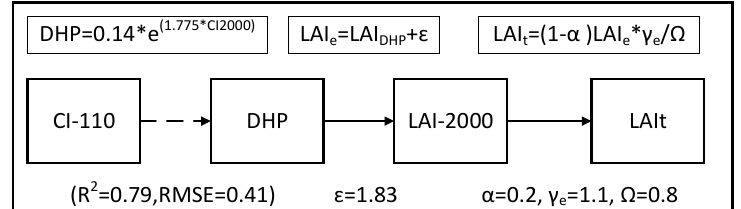
Figure A5. Flowchart of LAI field data processing procedures. Before January 2007, monthly LAI was measured using a CI-110 instrument, and a DHP instrument was used afterwards.